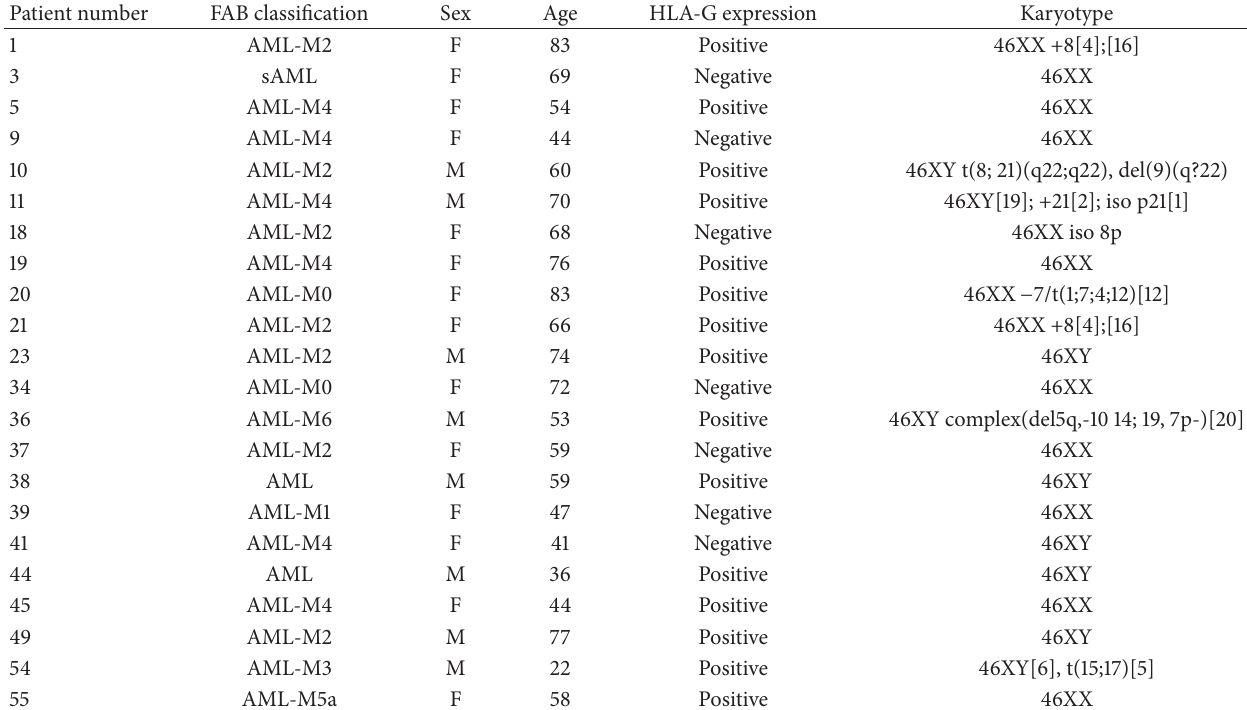
Table 2: HLA-G expression and cytogenetic